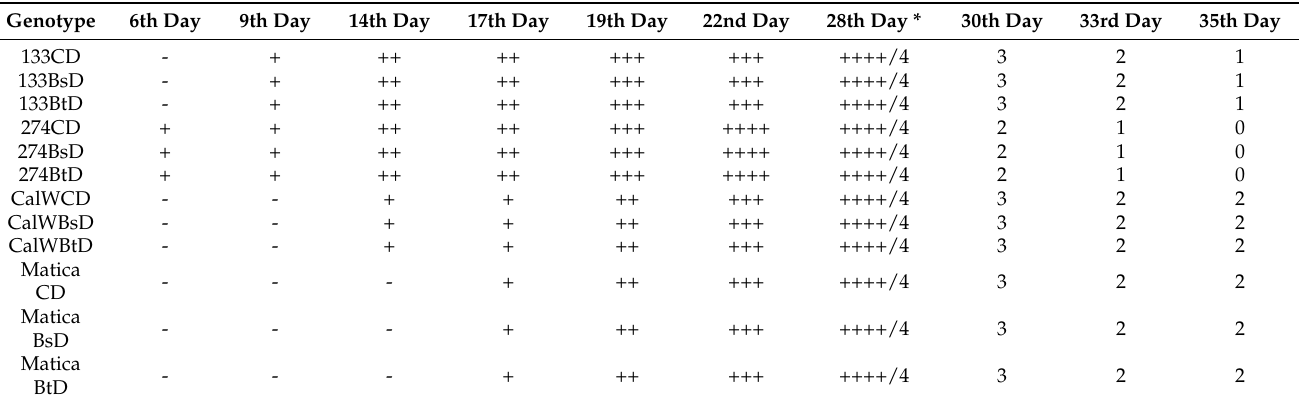
Table 3. Description of visual assessment of seedling establishment, cotyledon and leaf development, and decay after drought stress application.